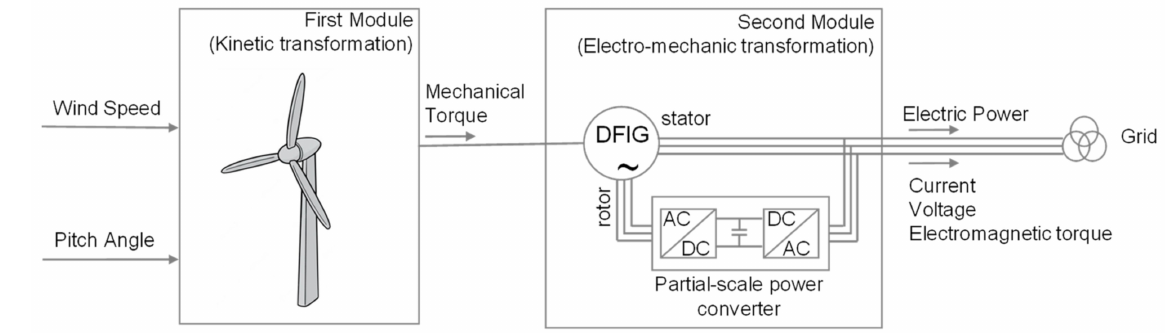
Figure 2. Physics-based model of the power conversion drivetrain of a wind turbine.